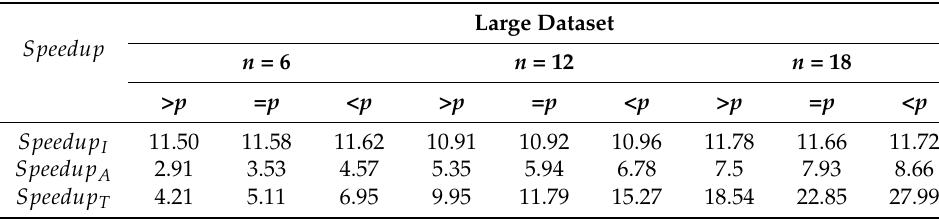
Table 8. Speedup obtained with a single card on Intel Xeon Phi (large dataset).